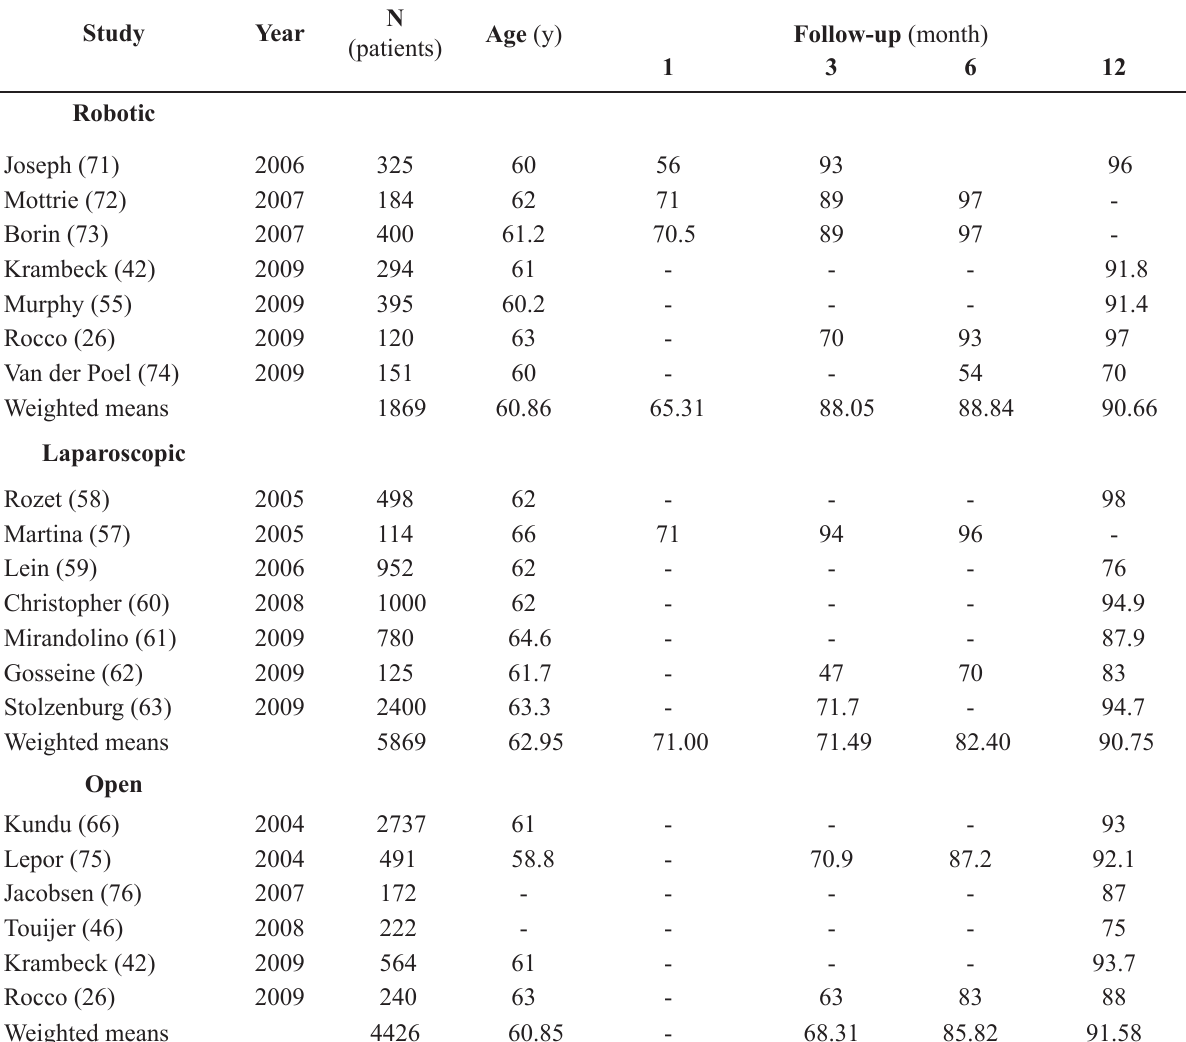
Table 3 – Continence of RRP, LRP and RALP